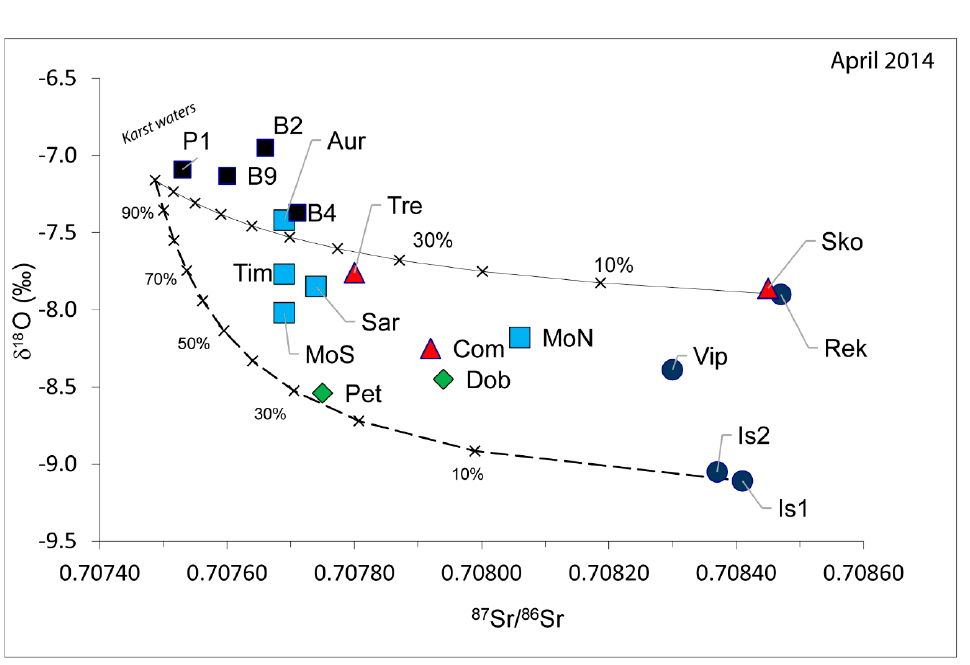
Figure 9. Isotopic ratio 87 Sr/ 86 Sr versus the δ 18 O (‰) values in water samples from April 2014. The dashed line represents a mixing line between waters having characteristics in between karst waters and So č a/Isonzo River waters; the continuous line instead, represents a mixing line between waters having characteristics in between karst waters and Reka River waters.